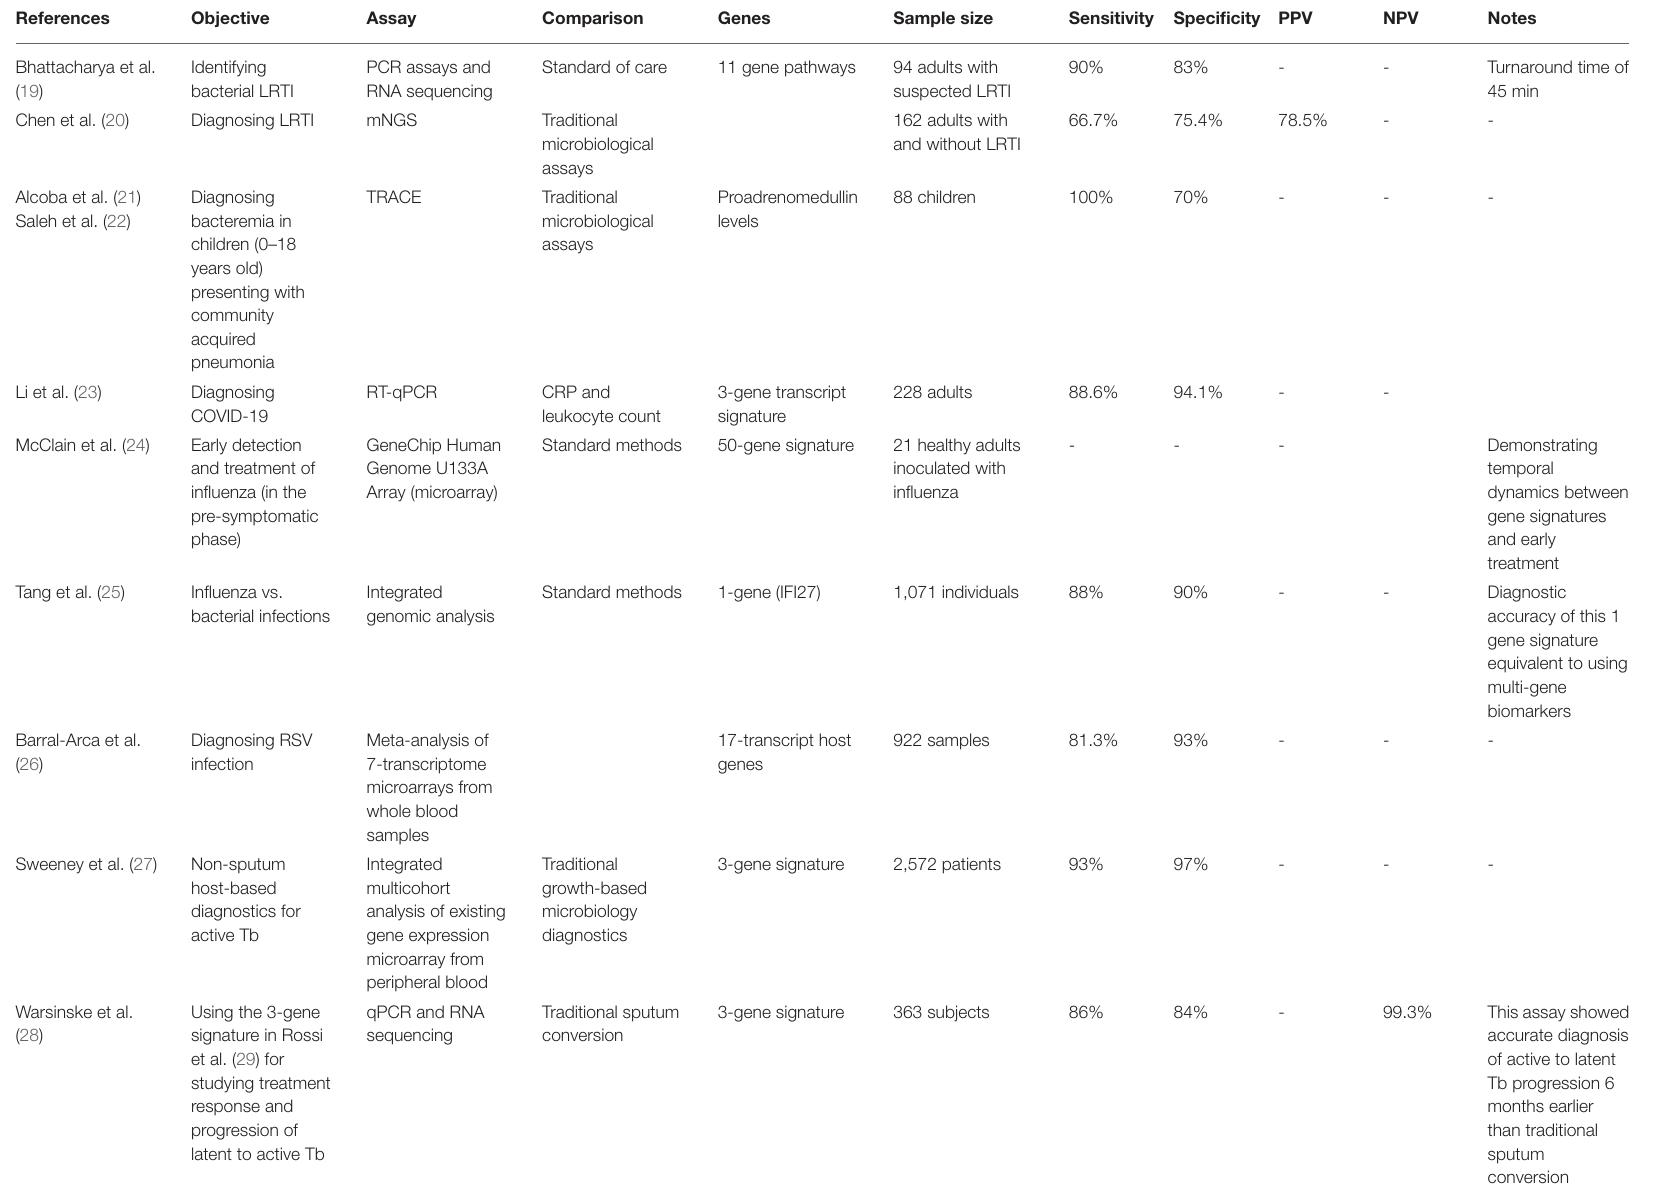
TABLE 2 | Results of using host-response diagnostics for identifying respiratory